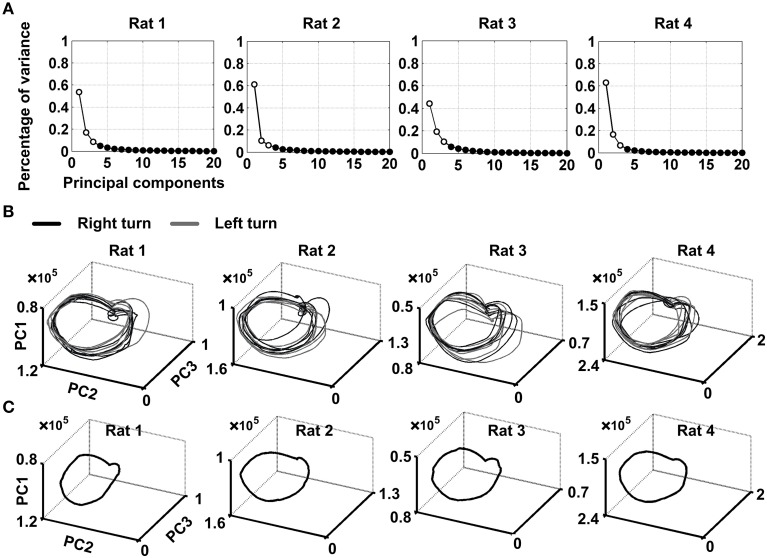
Visualization of neural trajectories representing multiple single-unit activity over time. (A) Scree plot of the principal components (PCs) obtained from the smoothed firing rate. The PCs were calculated over 10 correct trials for each rat via KPCA. Time slice points calculated from neuronal spike activity of four rats, projected onto state space using the first three PCs. The minimum embedding dimension m = 3 and the optimal time delay τ = 200 ms were applied for time-delay embedding. (B) Shown were 10 individual-trial neural trajectories for each rat. Gray arrows indicated the direction of evolution of neural trajectories during working memory. (C) Trajectory averaged over 10 trials for each rat.